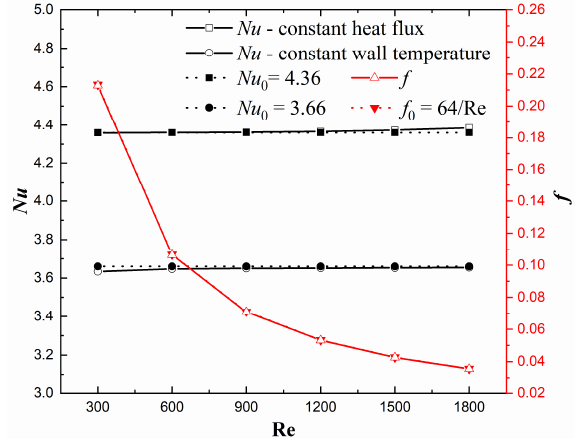
Figure 6. The results verification for the smooth circular tube.